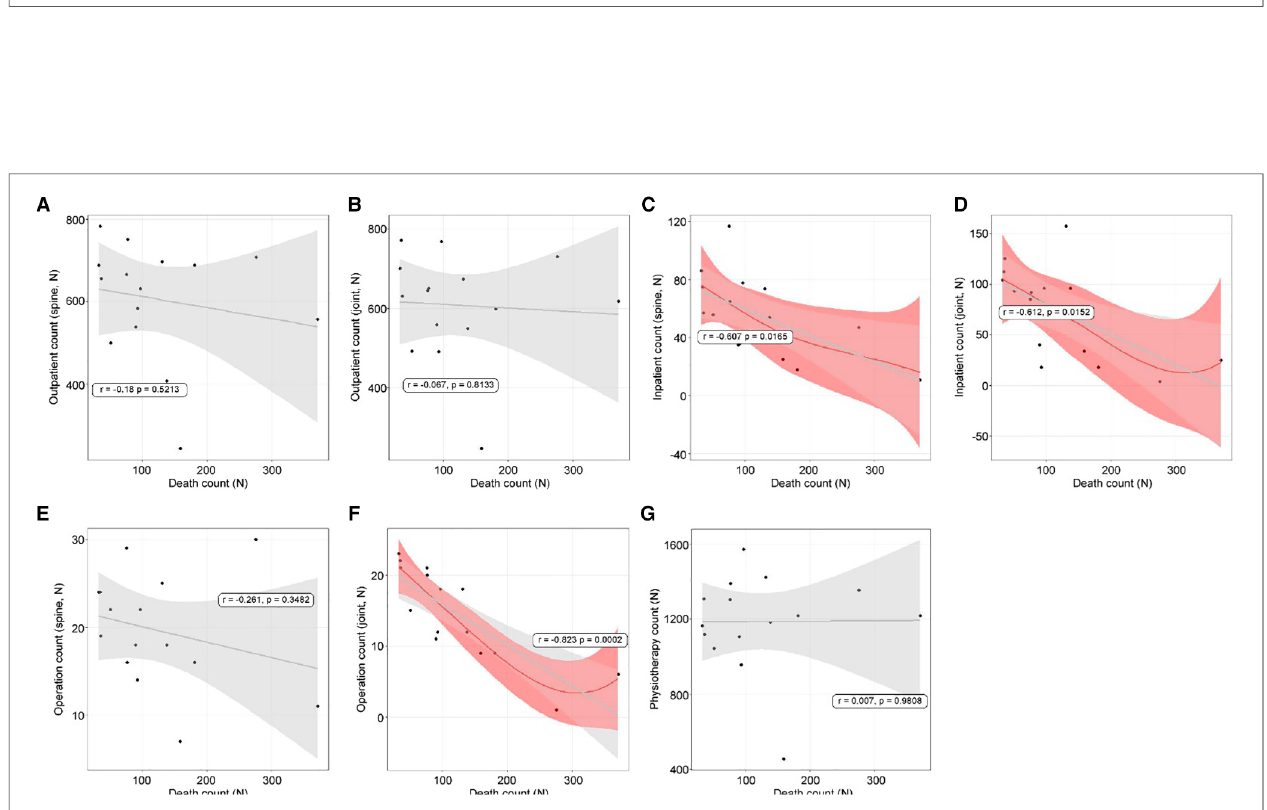
FIGURE 5 | The linear relationships between death counts and orthopedic hospital visiting patterns. ( A ) Spine outpatient count; ( B ) Joint outpatient count; ( C ) Spine inpatient count; ( D ) Joint inpatient count; ( E ) Spine operation patient count; ( F ) Joint operation patient count; ( G ) Physiotherapy patient count.